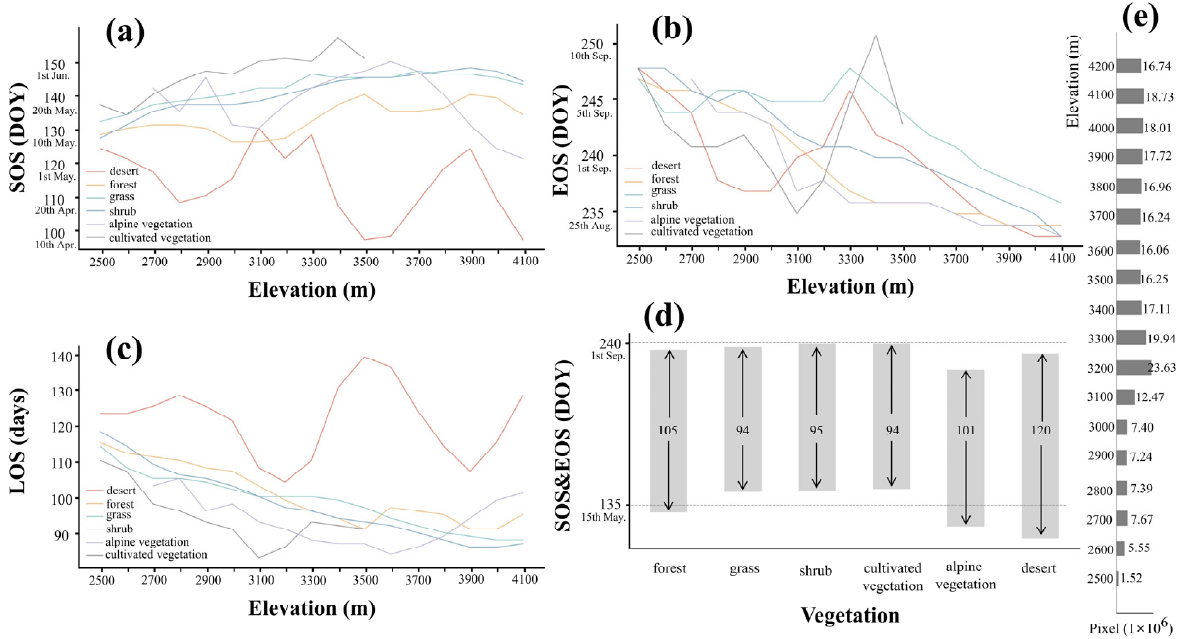
Figure 6. The calculated LSP metrics for the different vegetation types change with elevation. ( a ) represents the SOS, ( b ) represents the EOS and ( c ) represents the LOS. ( d ) shows the average of all elevations. The bar graph represents the average SOS and EOS of six different vegetation types, and the arrows inside the bar indicate their LOS. ( e ) shows the histogram of pixel numbers of different elevation gradients.